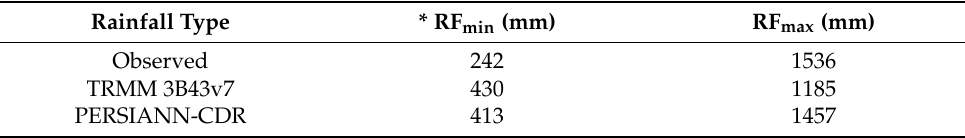
Table 3. Satellite products and ground observed rainfall